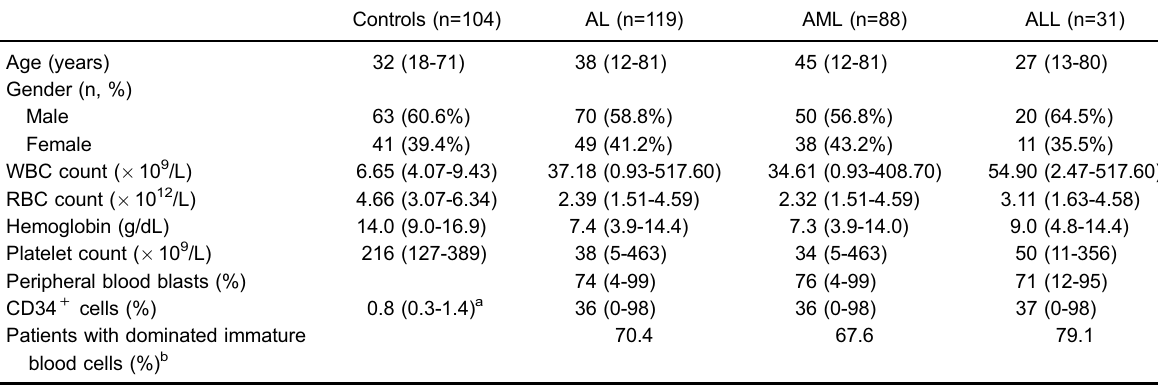
Table 1. Characteristics of normal healthy individuals and patients with acute